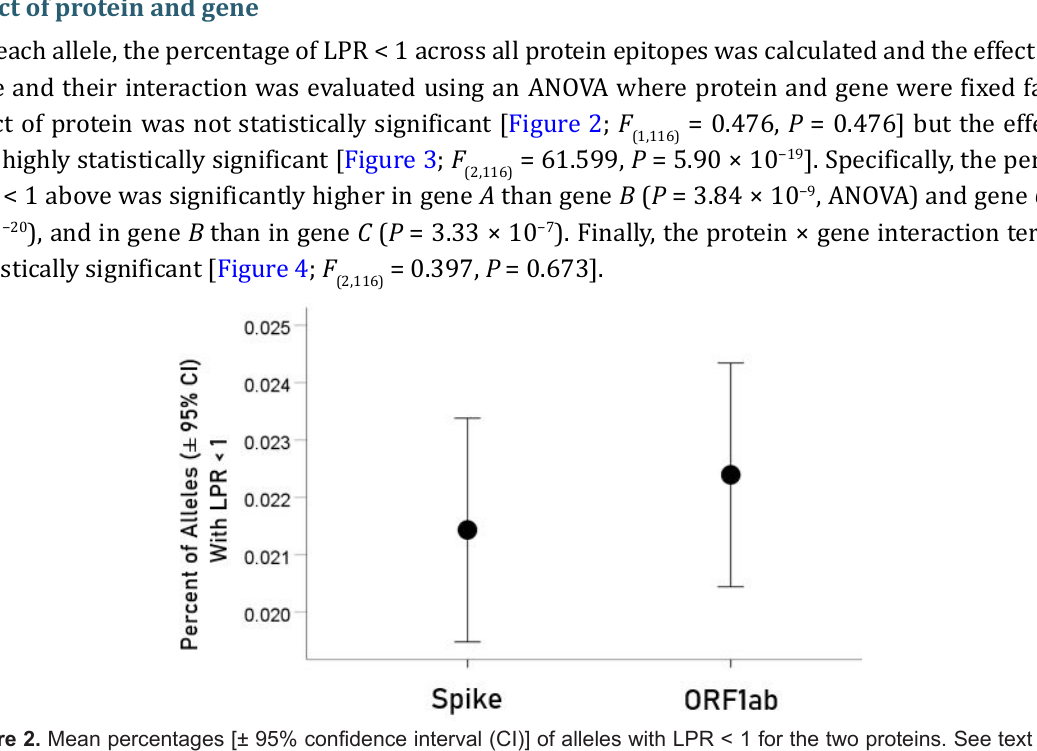
Figure 2. Mean percentages [± 95% confidence interval (CI)] of alleles with LPR < 1 for the two proteins. See text for details of statistical comparisons